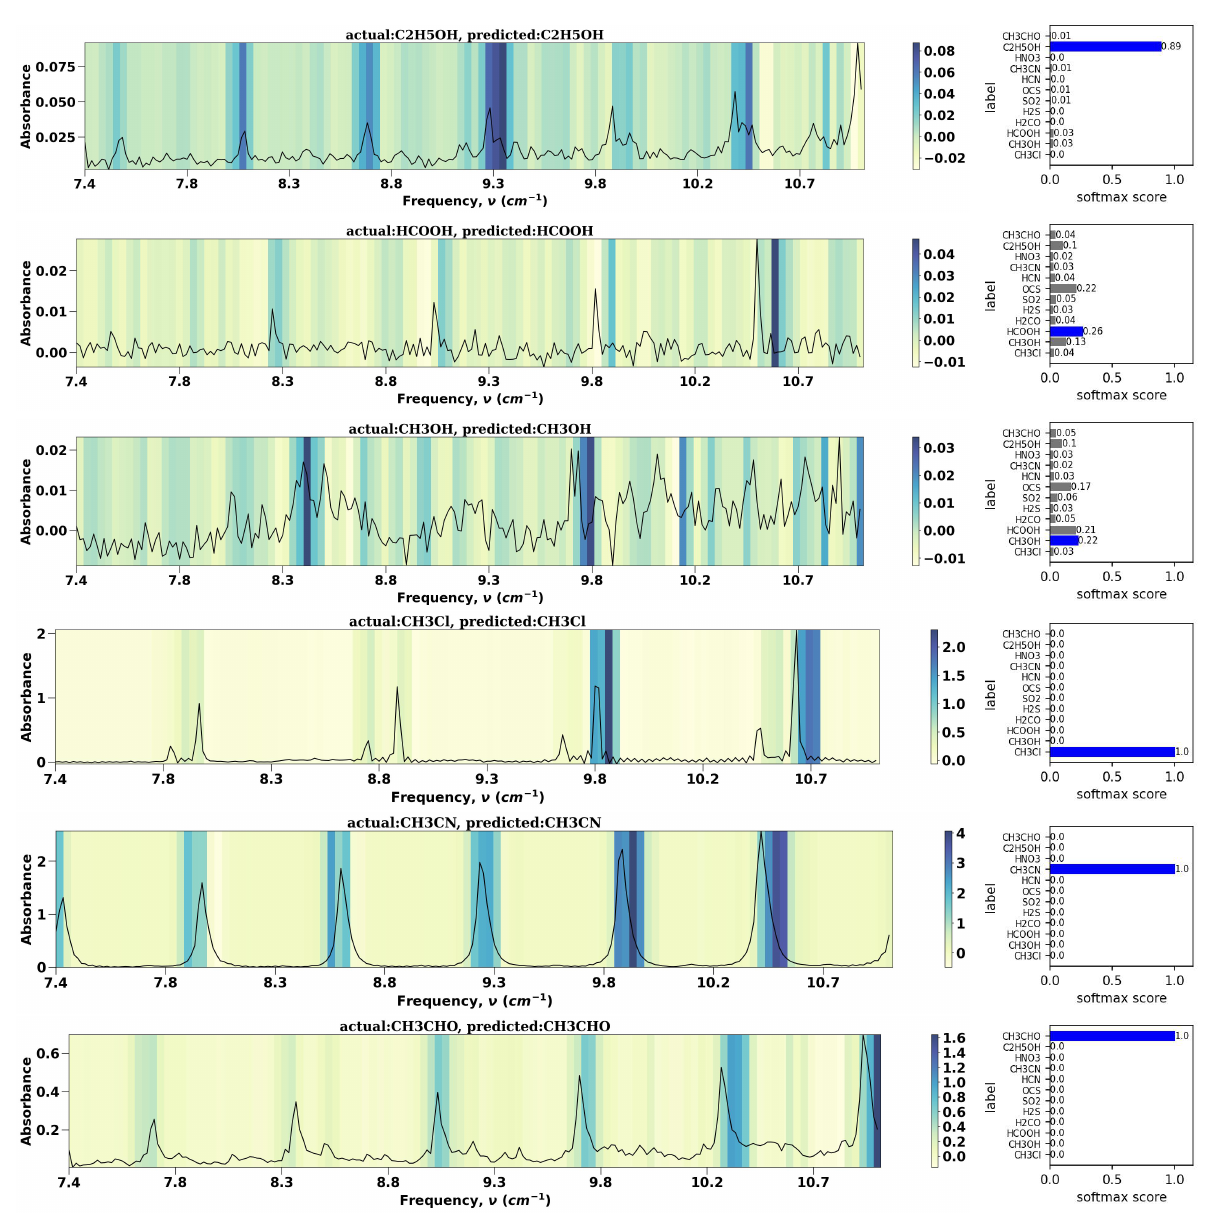
Figure 16. Class activation maps for the classification of six experimental spectra (No. 1, 7, 13, 19, 25, and 31). All of these spectra were correctly classified. The corresponding softmax scores are shown next to each class activation